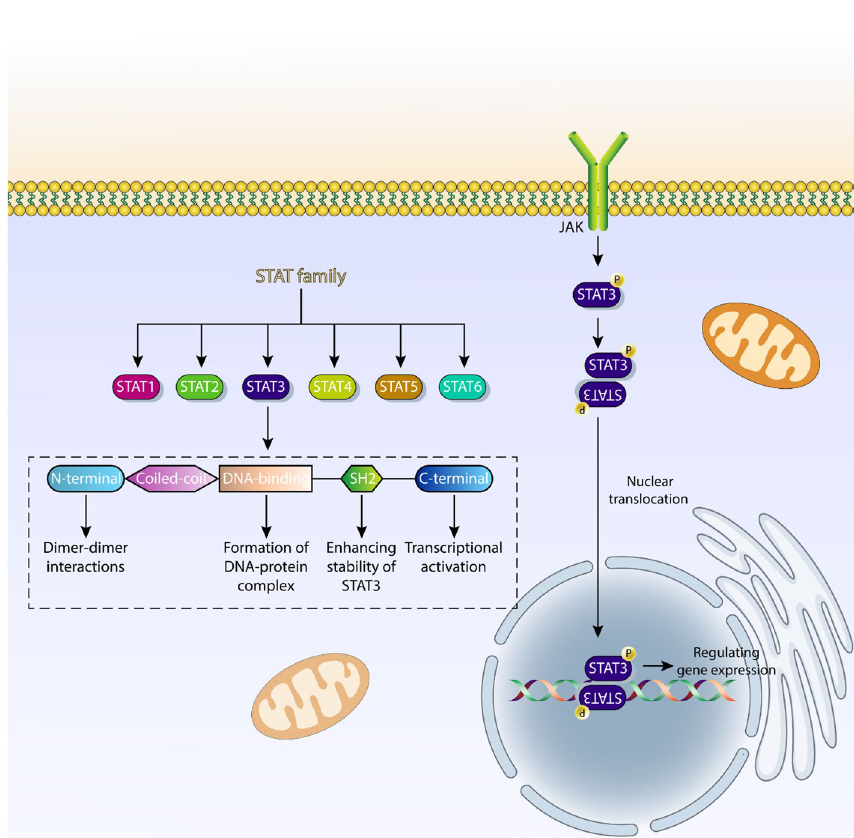
Fig. 1 A schematic representation of STAT3 in